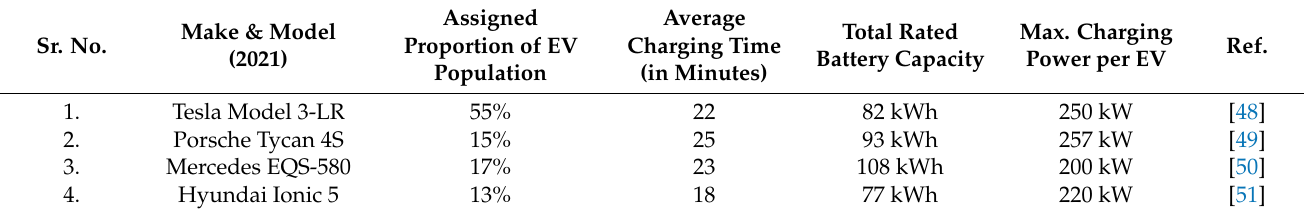
Table 3. Specifications of different EVs considered in the load profile for the 250 kW charging level.